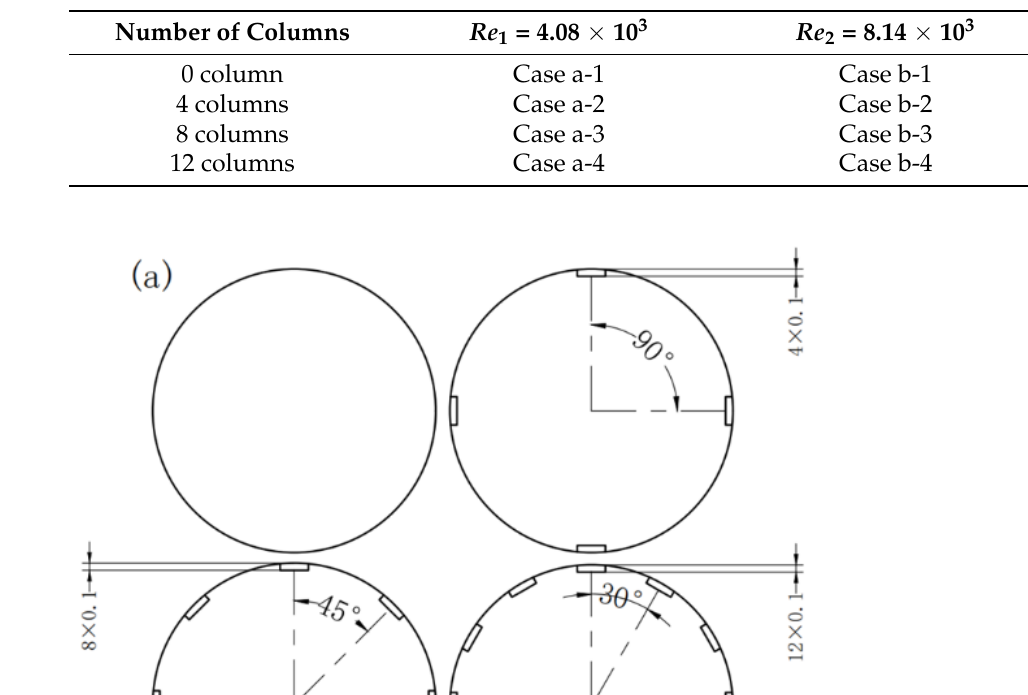
Table 7. Covered experimental conditions. Q (m 3 /h)